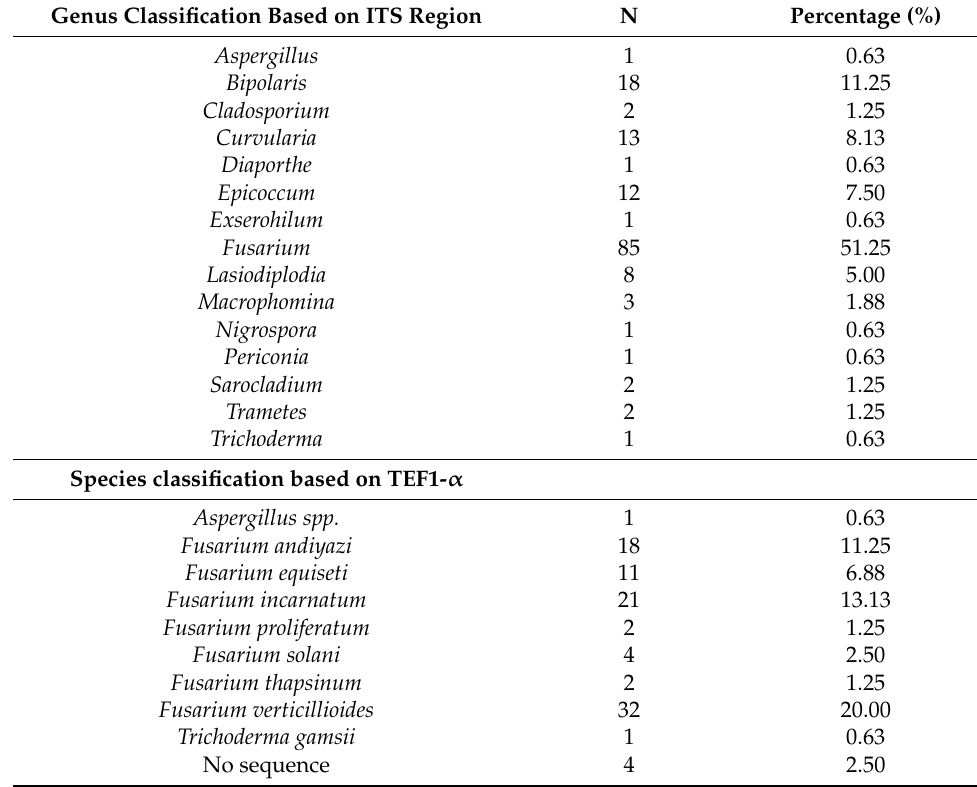
Table 1. Fungal genera and species isolated from grains in northern Uganda ( n = 160). Genus Classification Based on ITS